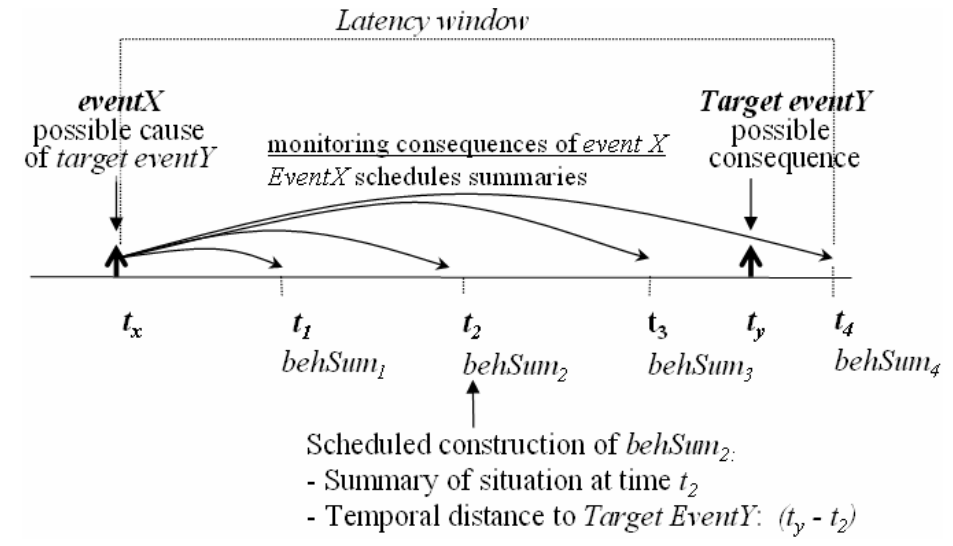
Fig. 2. Monitoring the consequences of an Figure 2. Monitoring the consequences of an event.